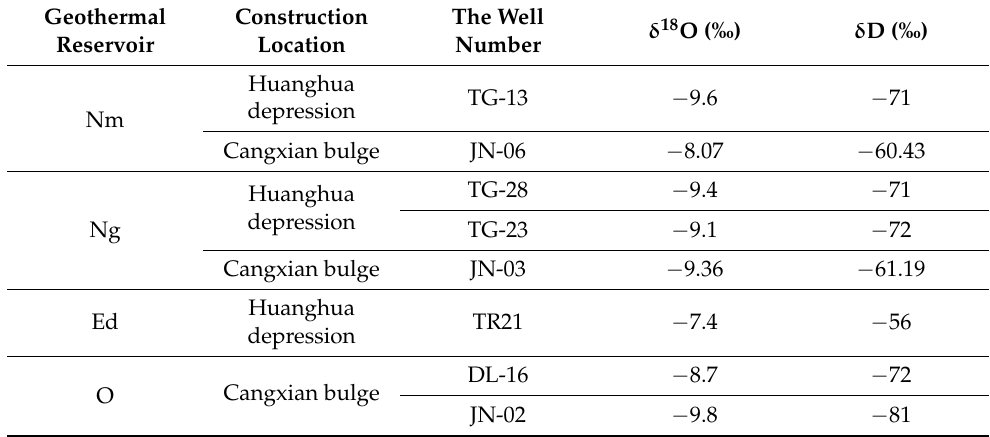
Table 7. Statistics table of the hydrogen and oxygen isotope data of the geothermal fluid in each geothermal